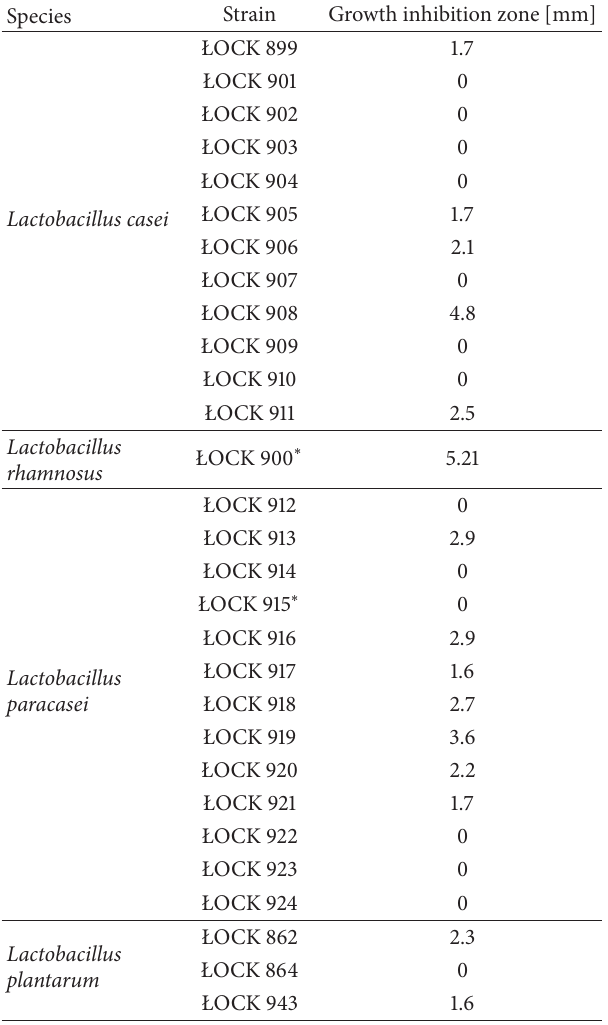
Table 1: Antagonistic activity of lactic acid bacteria